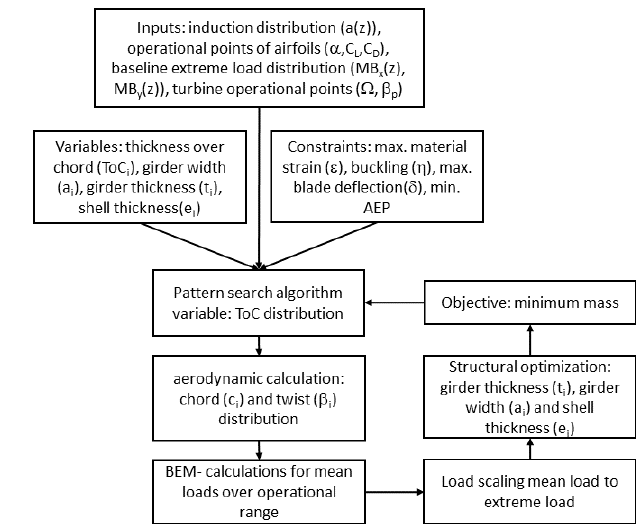
Figure 3. Flow chart of the optimization routine with STORM.